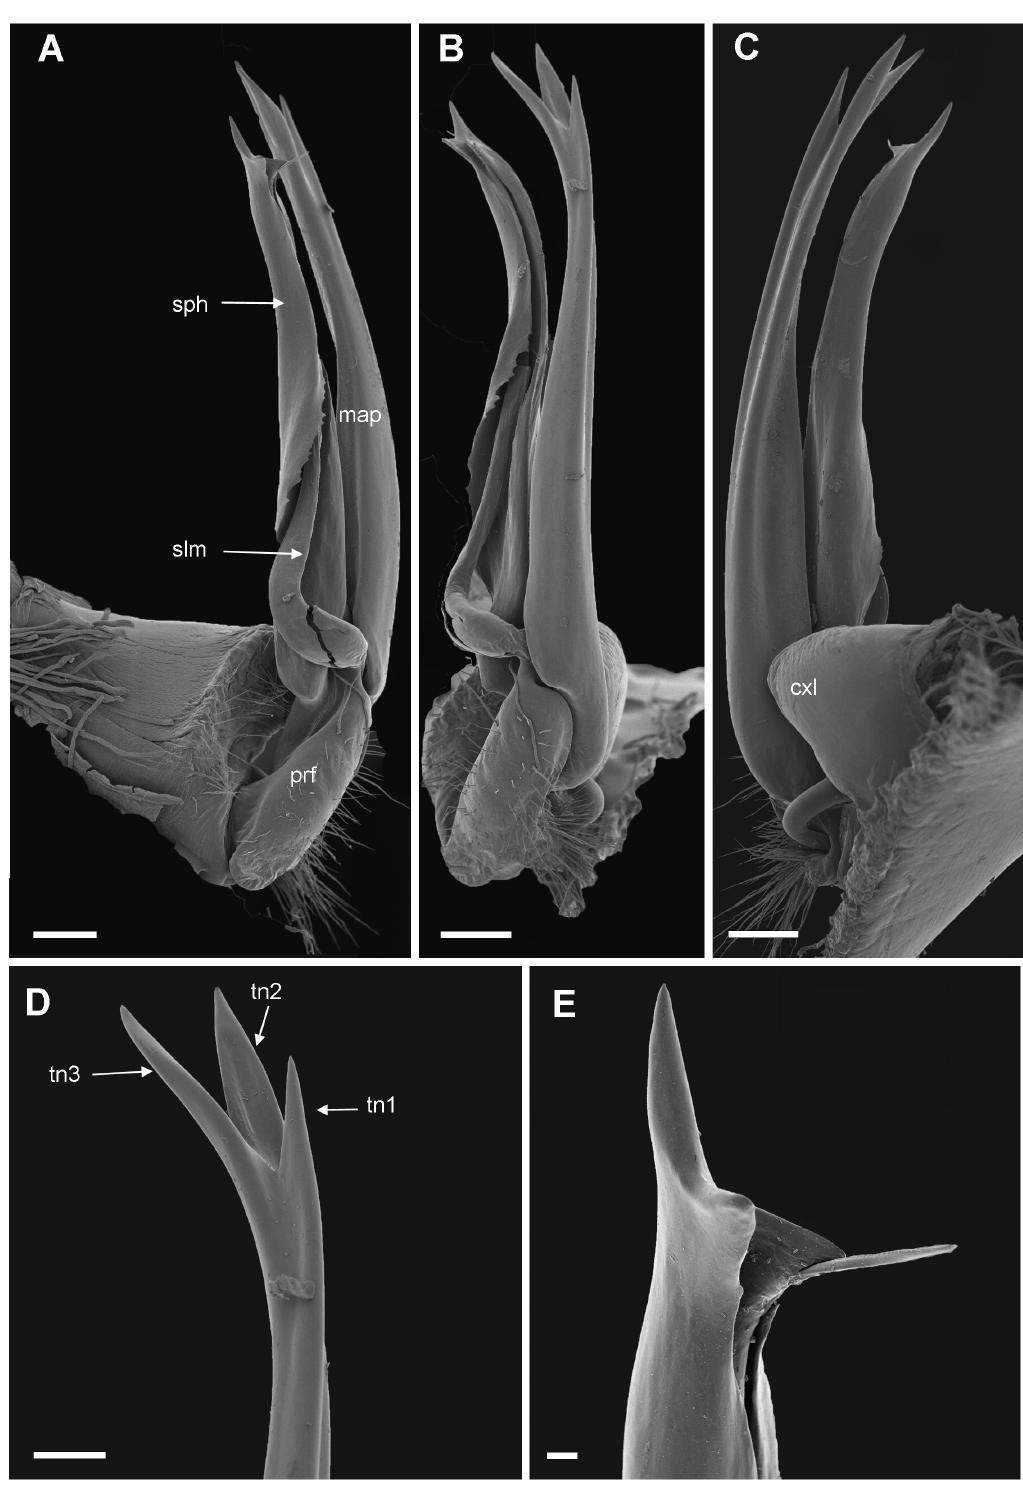
Fig. 29. Eviulisoma kangense sp. nov., paratype, right gonopod. A . Lateral view. B . Ventral view. C . Mesal and slightly dorsal view. D . Tip of mesal acropodital process ( map ). E . Tip of solenomere. Aluminium tape used for mounting visible in lower right part of C. Abbreviations: cxl = coxal lobe; map = mesal acropodital process; prf = prefemoral part; slm = solenomere; sph = solenophore; tn1 , tn2 , tn3 = apical tines of process map . Scale bars: A–C = 0.2 mm; D = 0.1 mm; E = 0.02